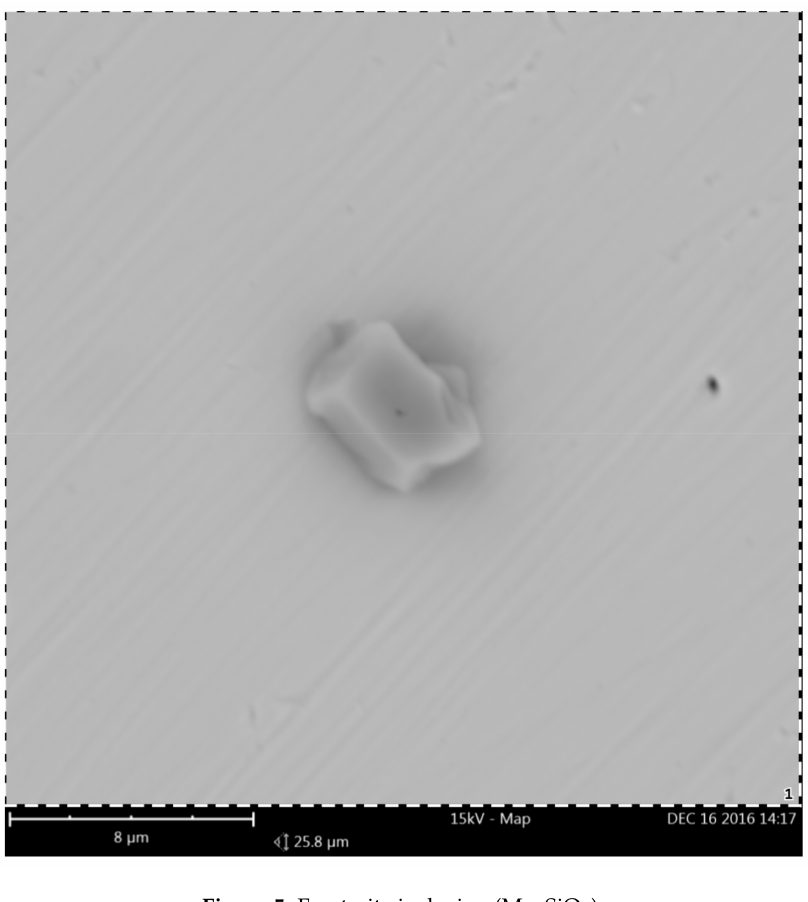
Figure 5. Forsterite inclusion (Mg 2 SiO 4 ).